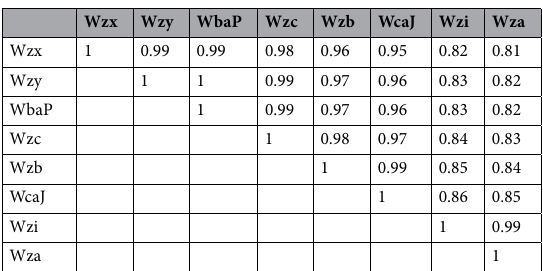
Table 1. The relative reliability factor (RRF) calculated using the ARS corresponding to the reference dataset (Table S1